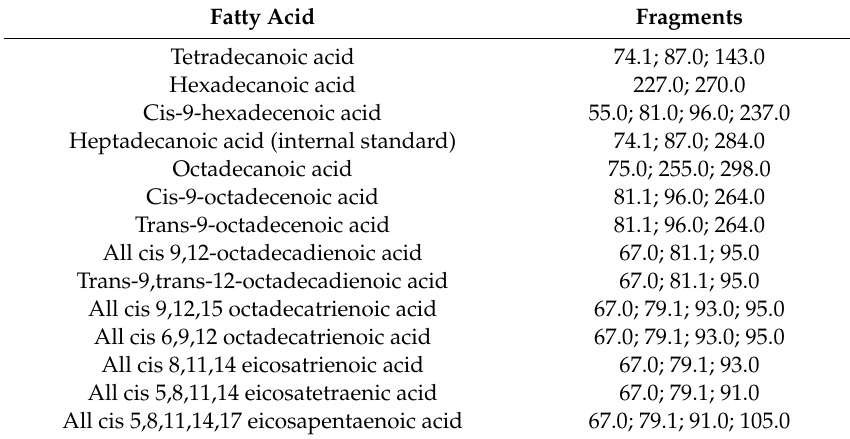
Table 3. Plasma fatty acids assayed by gas chromatography-electron ionization-mass spectrometry. Fatty